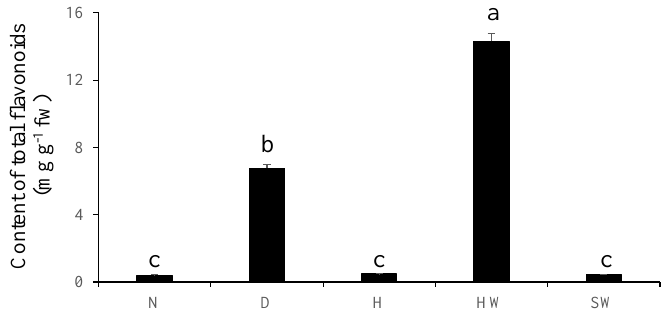
Figure 2. The total contents of total flavonoids in the N, D, and H zones of pruned stem, natural heartwood (HW), and sapwood (SW).